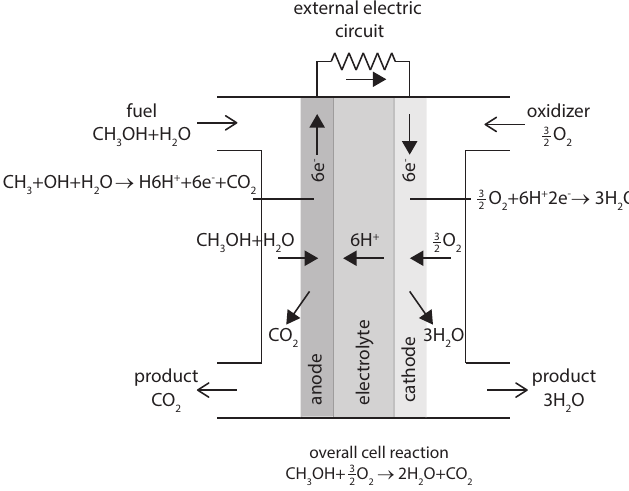
Figure A3. Schematic of a